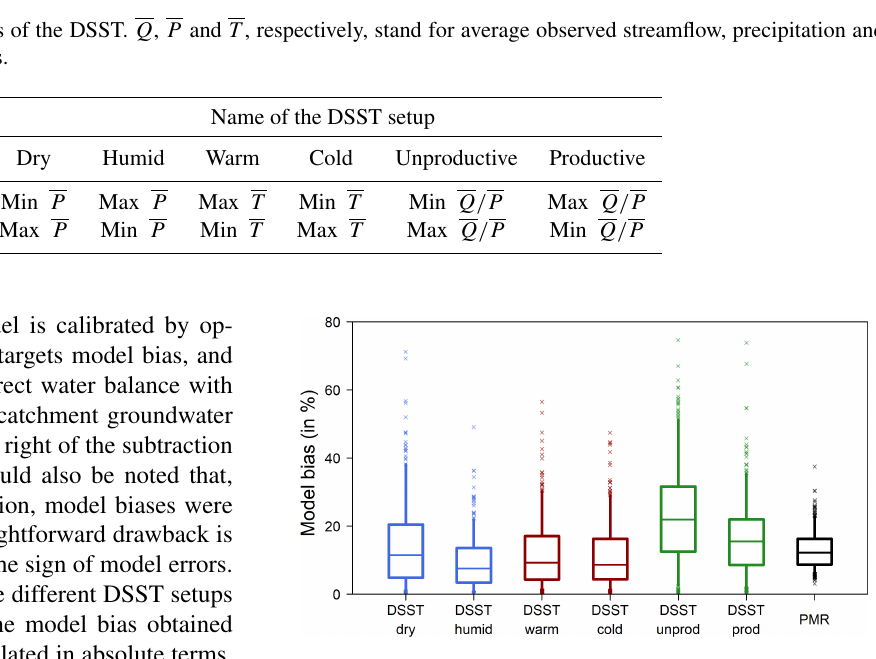
Figure 4. Distribution over the catchment set of the absolute value of model bias in DSST for each type of setup compared to PMR val- ues. The box plots represent the 5, 25, 50, 75 and 95 quantiles, and the crosses denote the outliers. Blue, red and green box plots are, respectively, associated to the DSST setups based on precipitation, temperature and runoff